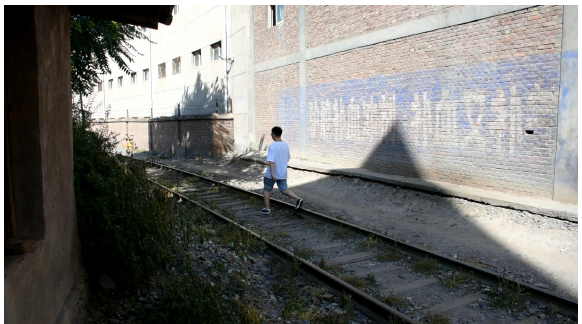
Fig. 11. The original image of the 285 th frame of video 3